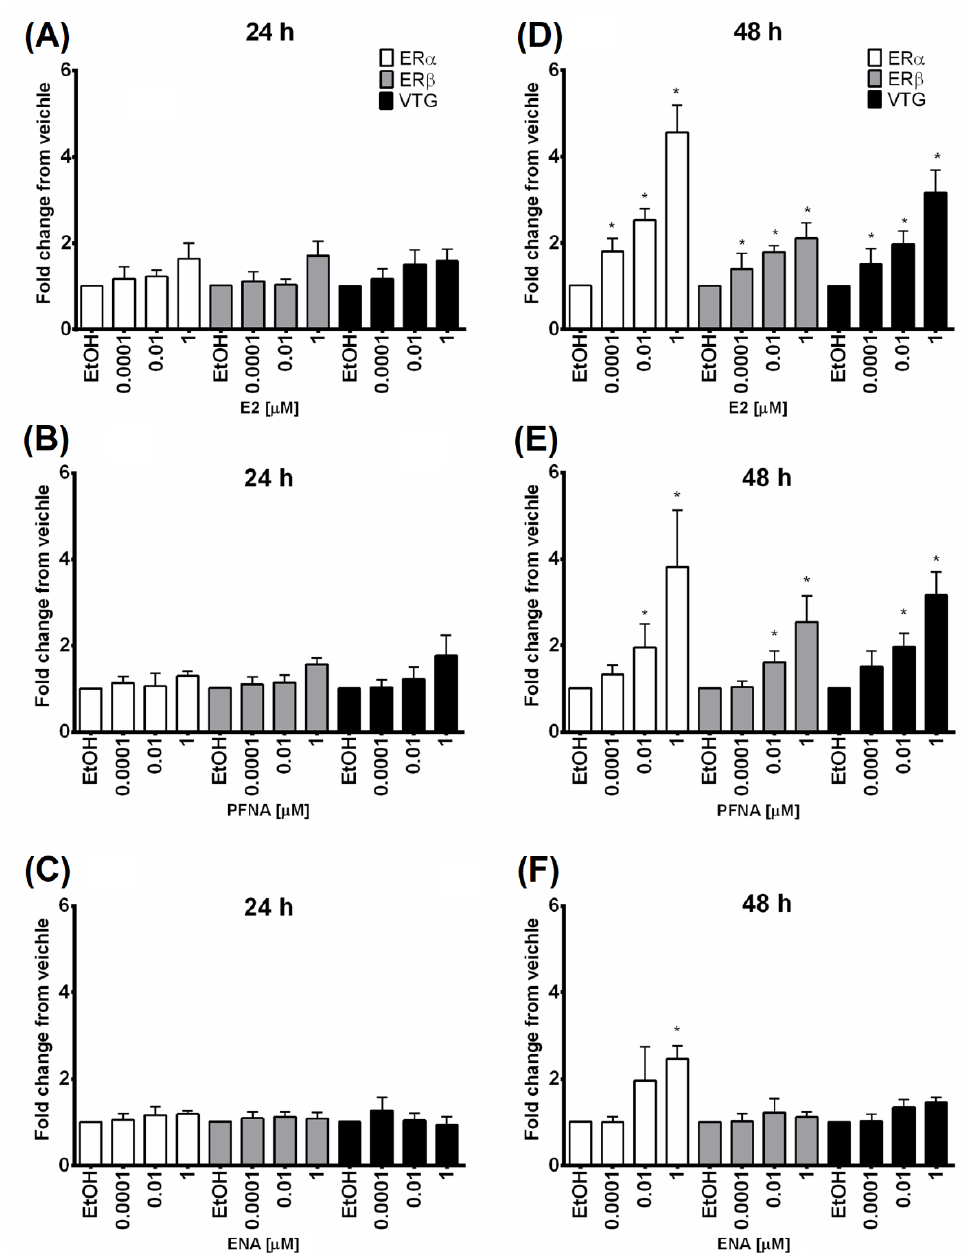
Figure 3. ER α , ER β and VTG mRNA expression profile (fold change from vehicle) in Mugil cephalus hepatocytes exposed to Figure 3. ERα, ERβ and VTG mRNA expression profile (fold change from vehicle) in Mugil cepha- different concentrations (0.0001–1 µ M) of E2 ( A , D ), PFNA ( B , E ), ENA ( C , F ) for 24 and 48 h. Values are mean ± SEM of lus hepatocytes exposed to different concentrations (0.0001–1 μM) of E2 ( A , D ), PFNA ( B , E ), ENA three independent experiments. “*” indicates significant differences between control and treated groups ( p < ( C , F ) for 24 and 48 h. Values are mean ± SEM of three independent experiments. “*” indicates sig- nificant differences between control and treated groups ( p < 0.05).